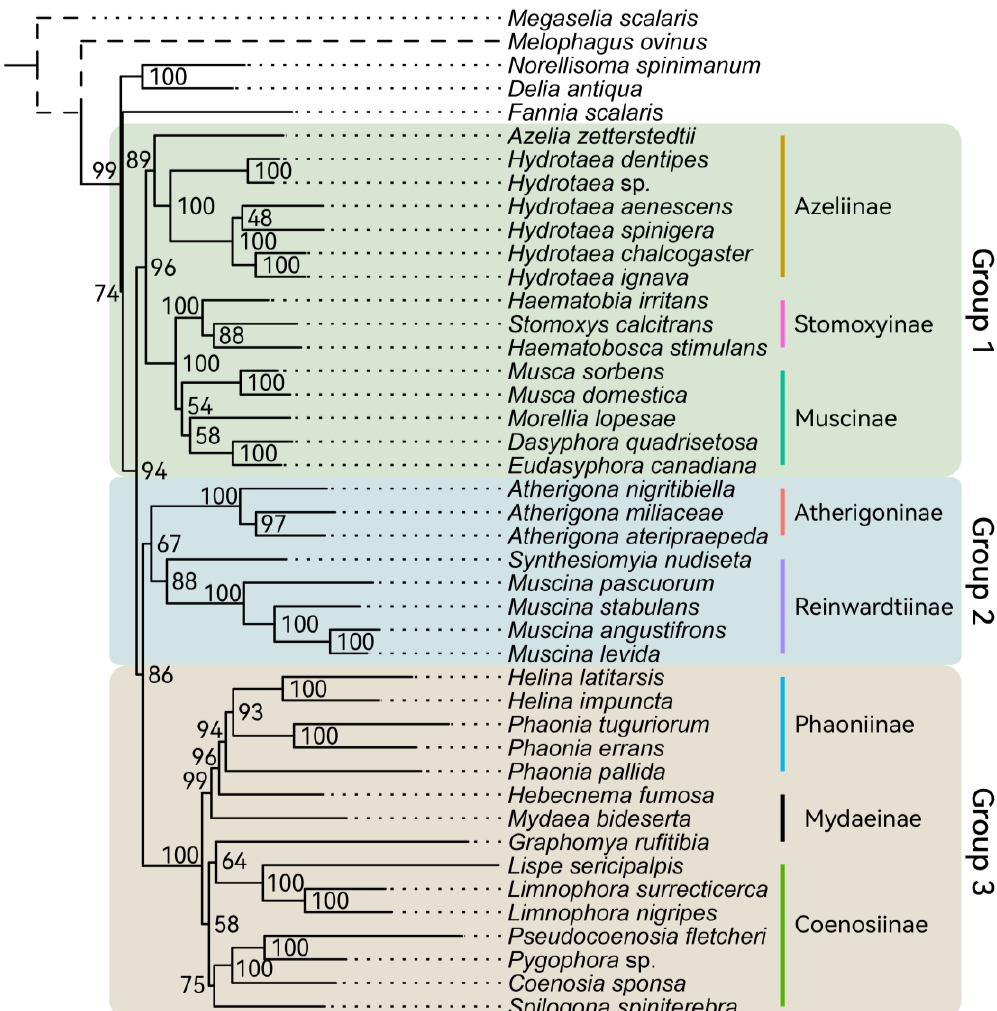
Figure 1. Phylogenetic analysis based on maximum likelihood method by IQ-TREE in Phylosuite software (dataset: C123TR-P2). The dashed branches were resized to better illustrate the tree.